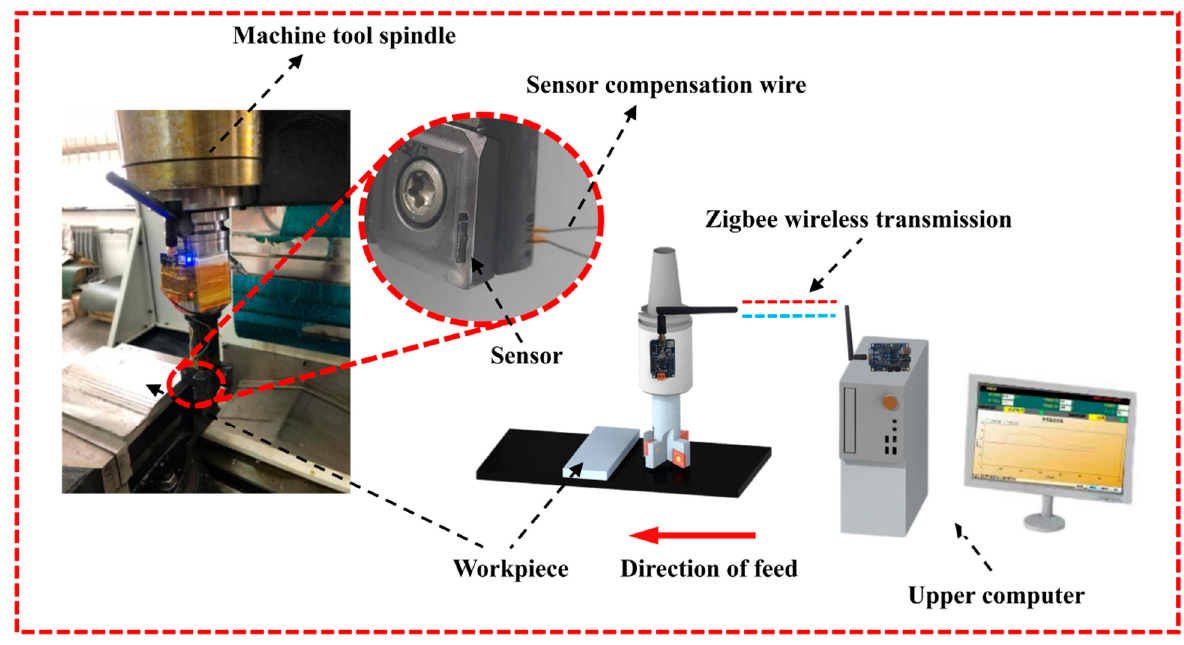
Figure 10. Wireless transient milling temperature measuring device.